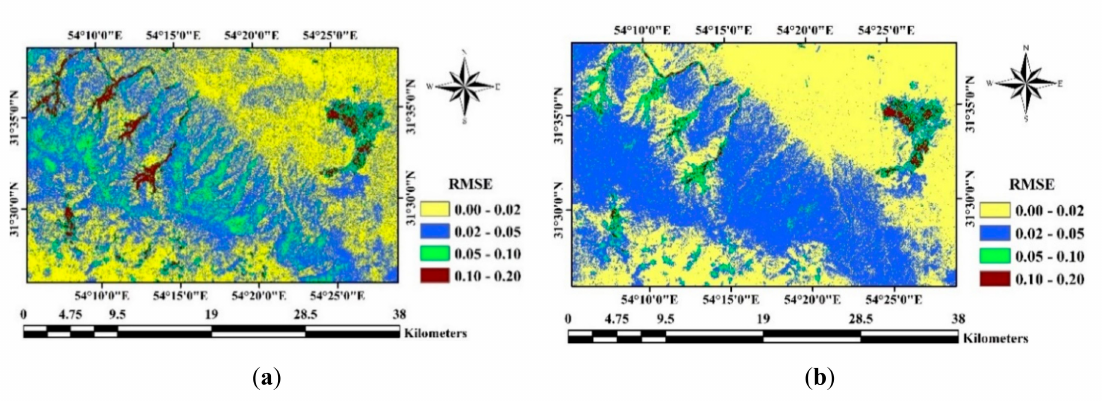
Figure 14. RMSE map of 15 original images extracted from the time series and reconstructed by HANTS algorithm ( a ) and M-SSA algorithm ( b ).